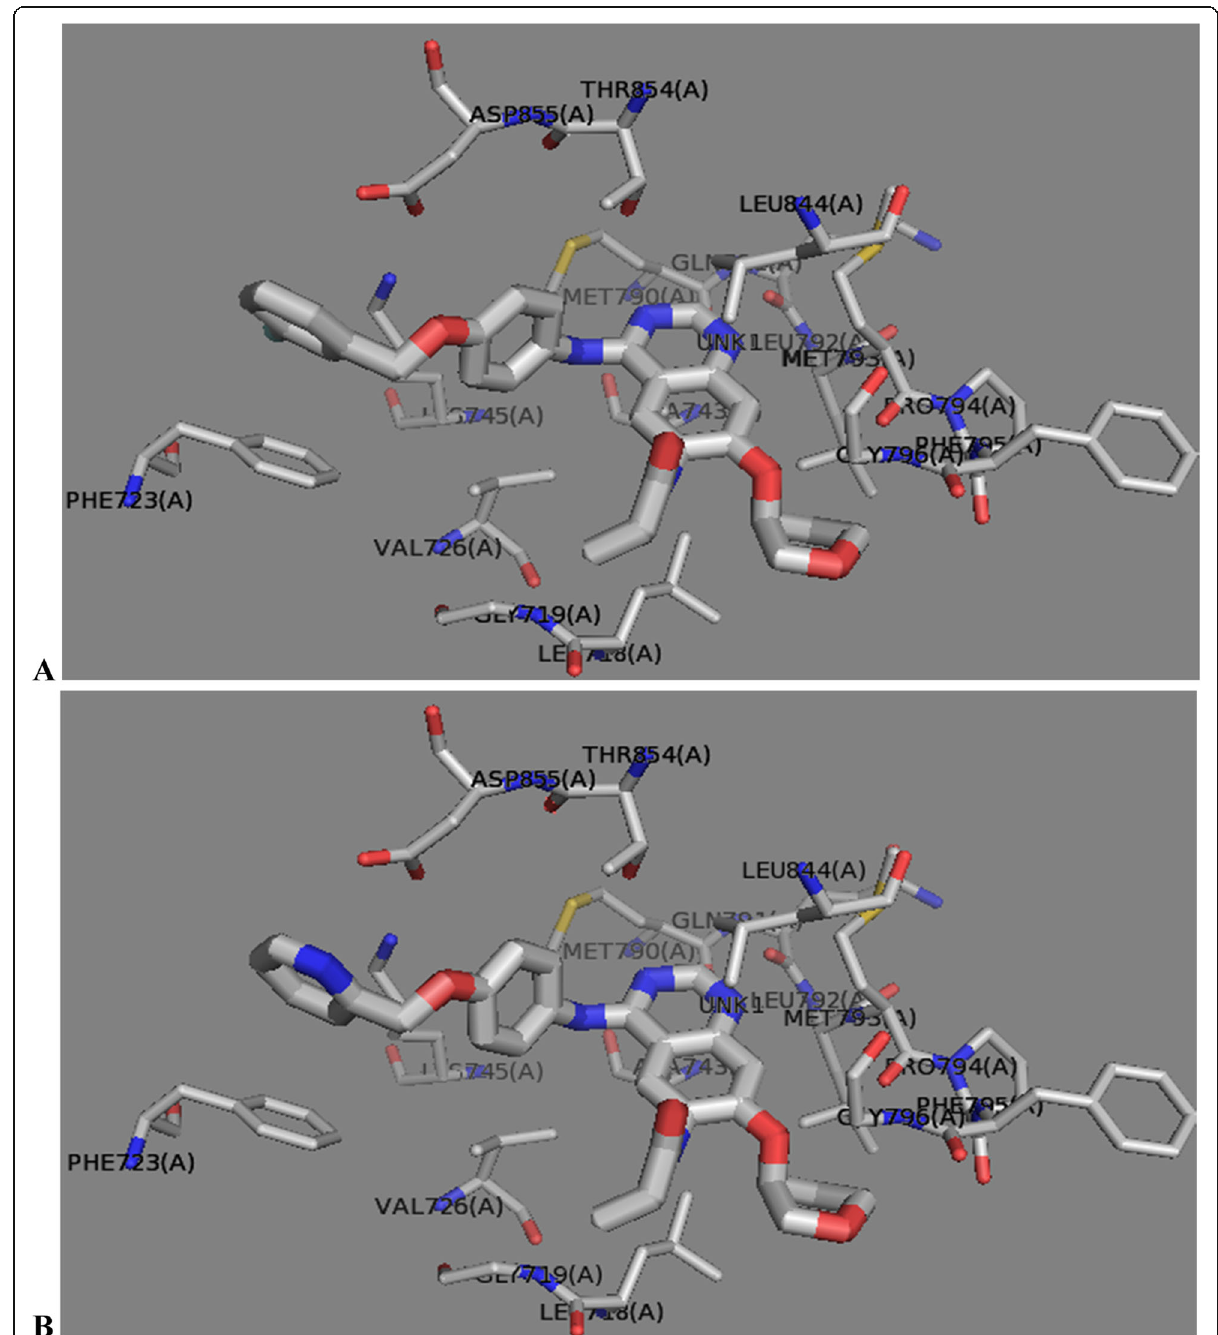
Fig. 3 The 2D structure of a Complex 6 and b Complex 8 using discovery